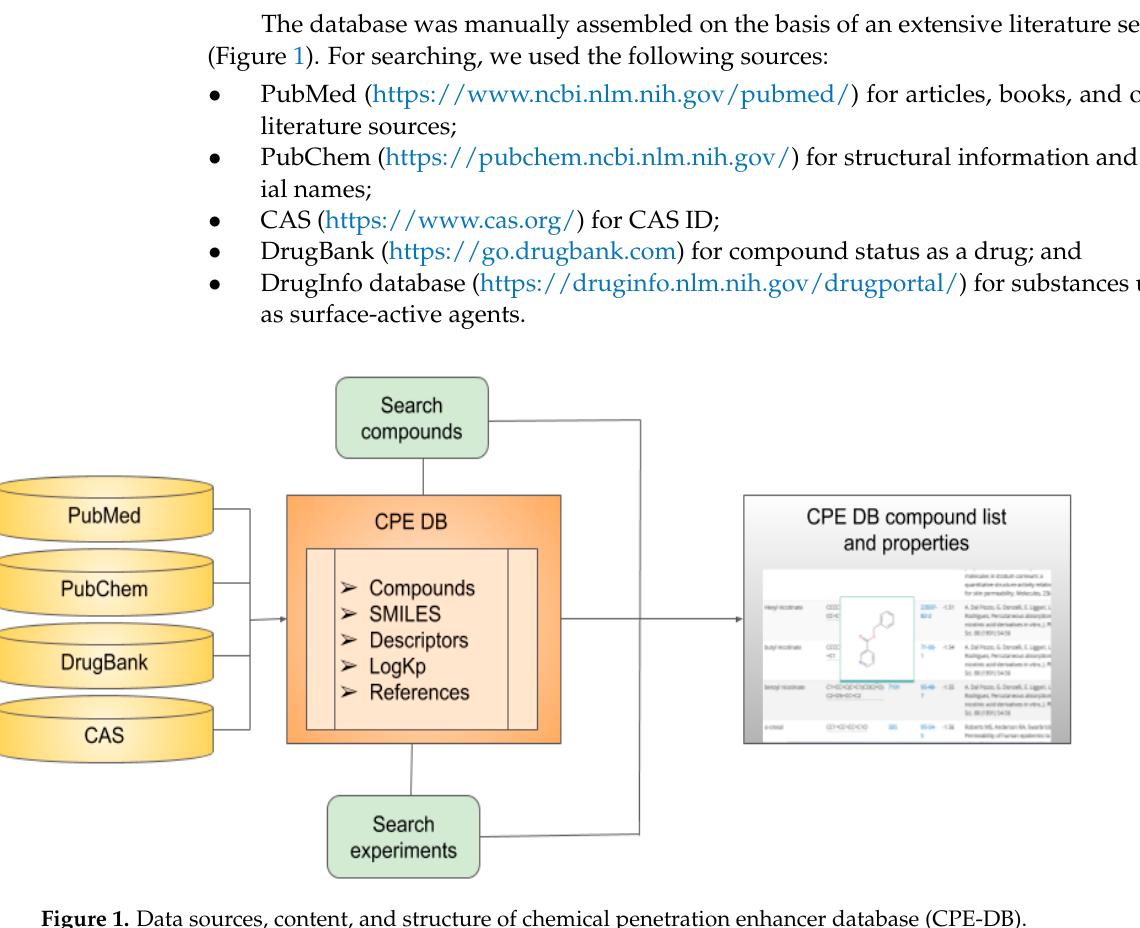
Figure 1. Data sources, content, and structure of chemical penetration enhancer database (CPE-DB).